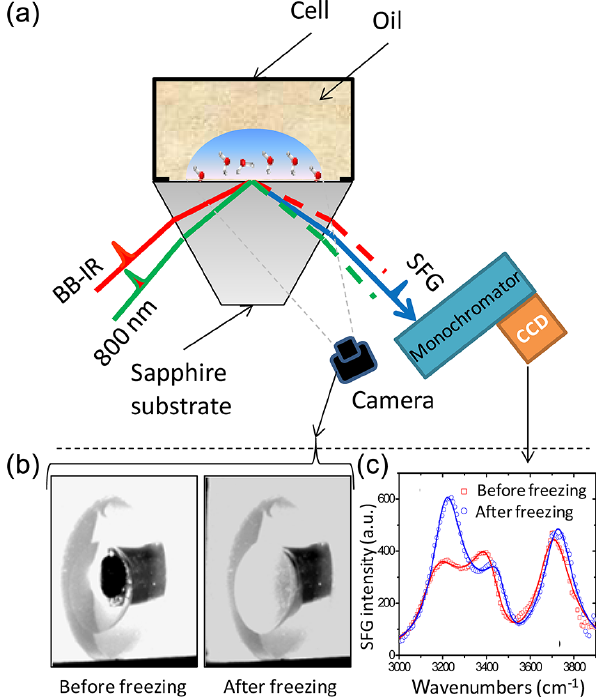
Figure 1. (a) Schematic of the sample setup used in the SFG exper- iments. The SFG signal is generated in a co-propagating total in- ternal reflection geometry at the spatial and temporal overlap of the incoming visible (800nm) and infrared (BB-IR) light, focused down to a ∼ 100µm diameter spot size. The camera (Guppy F-036, Allied Vision Technology, with LINOS macro-CCD lens 0.14 × (1 : 7) f 4) is used to observe the droplet while placing it on the surface and fill- ing the cell with oil, and to observe its status during the experiment. (b) Images of a typical drop on the substrate before and after freez- ing. (c) Typical water spectra before and after the